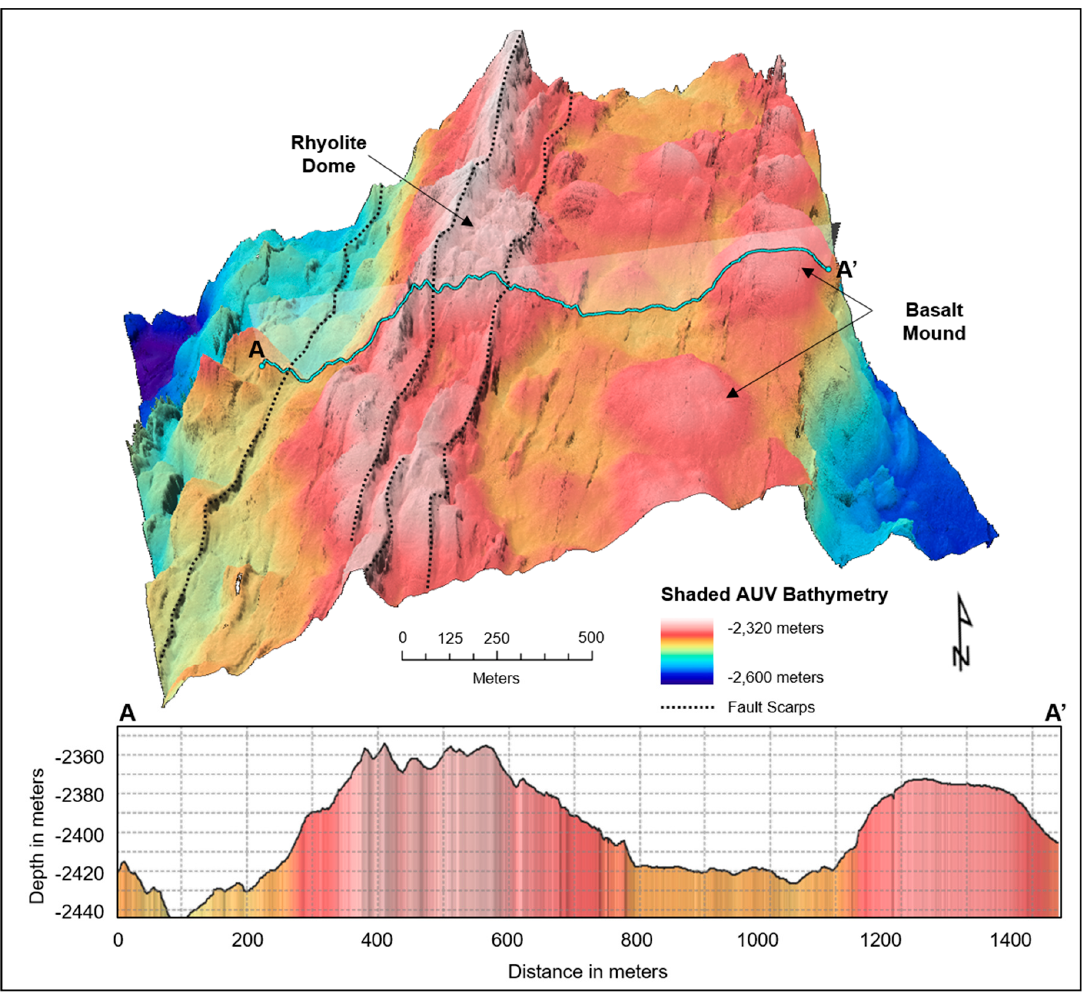
Figure 4. 3D perspective of the high-silica region in the north AOI at 3x vertical exaggeration. The rhyolite dome extrudes from a central ridge that separates the high-silica zone to the west. Lava on the rhyolite dome create a jagged texture of the seafloor. In contrast, quasi-circular basalt mounds have smoother surfaces in the AUV bathymetry. Geosciences 2018 , 8 , x FOR PEER REVIEW